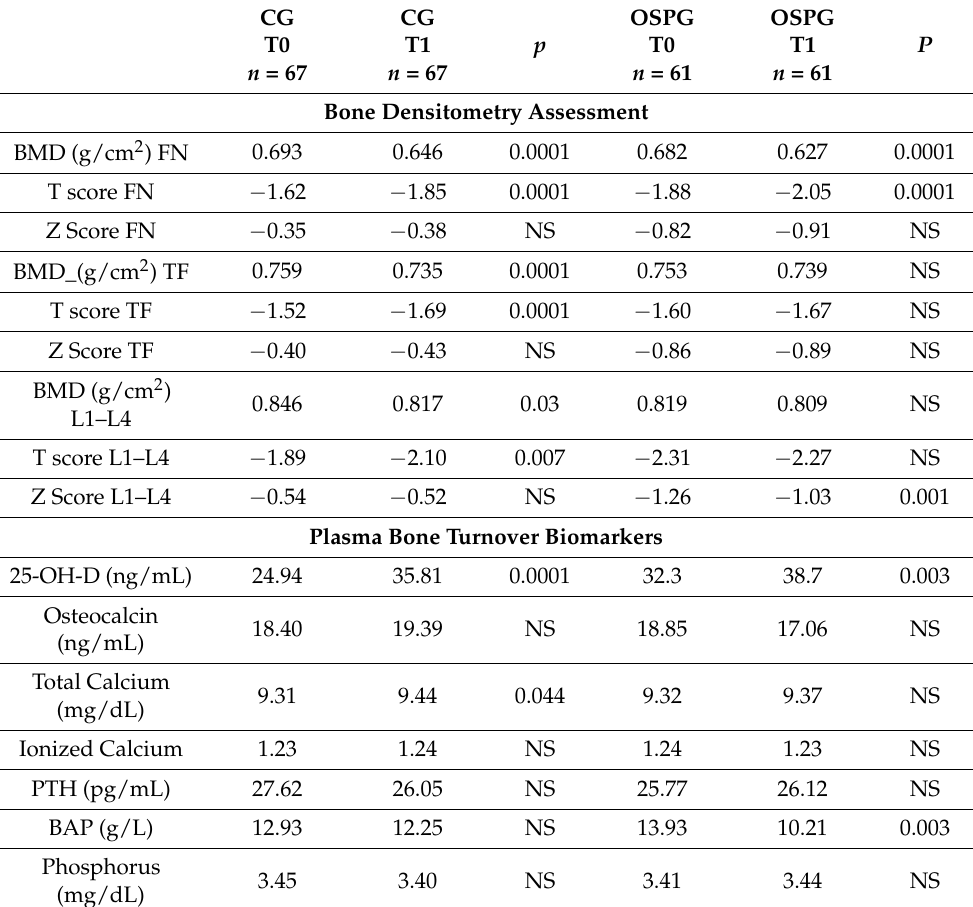
Table 1. Bone densitometry assessment and plasma bone turnover biomarkers in the control group (CG) and in the ospemifene group (OSPG) at T0 and T1. Data are expressed as mean ± standard deviation (SD). Abbreviations are as follows: BMD, bone mineral density; L1–L4, lumbar spine; FN, femoral neck; TF, total femur; BMD, bone mineral density; 25-OH-D, serum vitamin D; PTH, parathyroid hormone 1–84; BAP, bone alkaline phosphatase. NS: result not statistically significant. CG